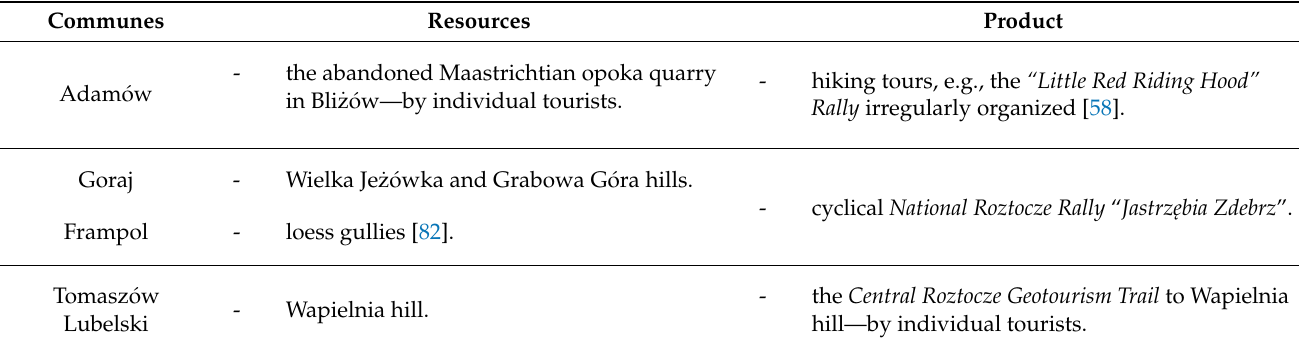
Table 14. Communes with a moderately developed (TGFI = 0.061–0.122) geotourism function. Communes